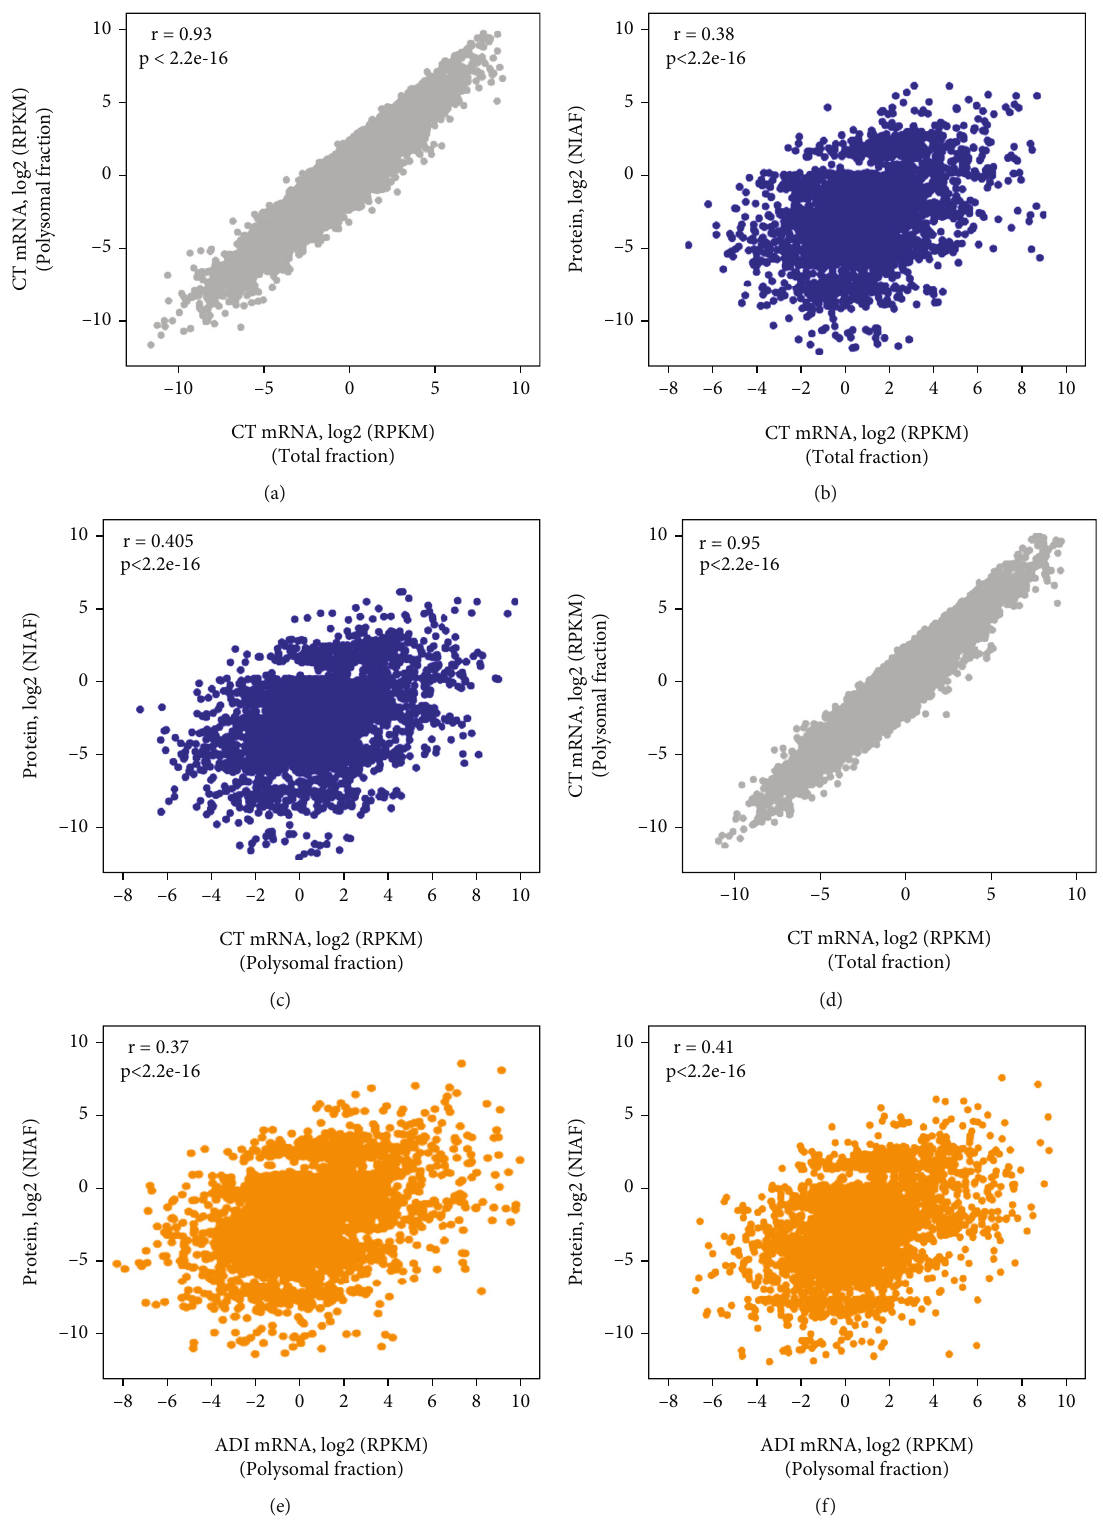
Figure 4: Relationship of identi fi ed proteins and mRNAs in control and induced hASC. (a) Correlation coe ffi cient of CT mRNAs from the total and polysomal fractions. (b, c) Proteins versus CT mRNAs from the total and polysomal fractions, respectively. (d) Correlation coe ffi cient of ADI mRNAs from the total and polysomal fractions. (e, f) Proteins versus ADI mRNAs from the total and polysomal fractions,